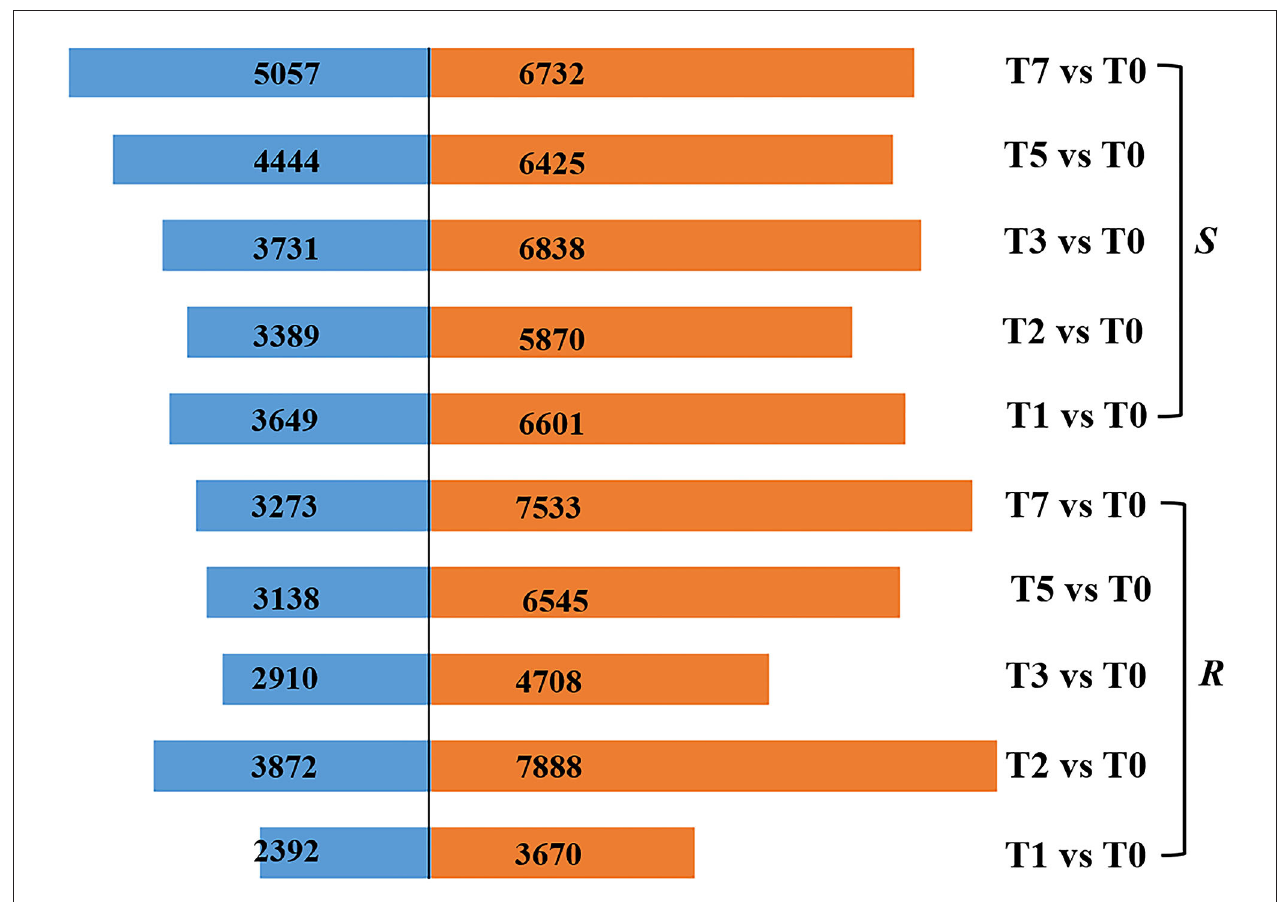
FIGURE 2 | DEGs in R and S at five time points post-inoculation (T1, T2, T3, T5, and T7) compared with T0.